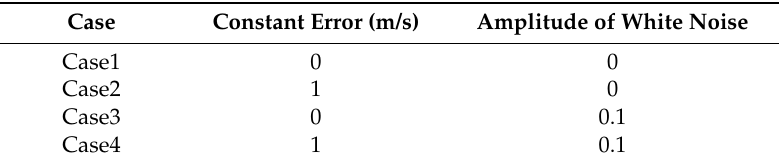
Table 3. Four cases of external reference